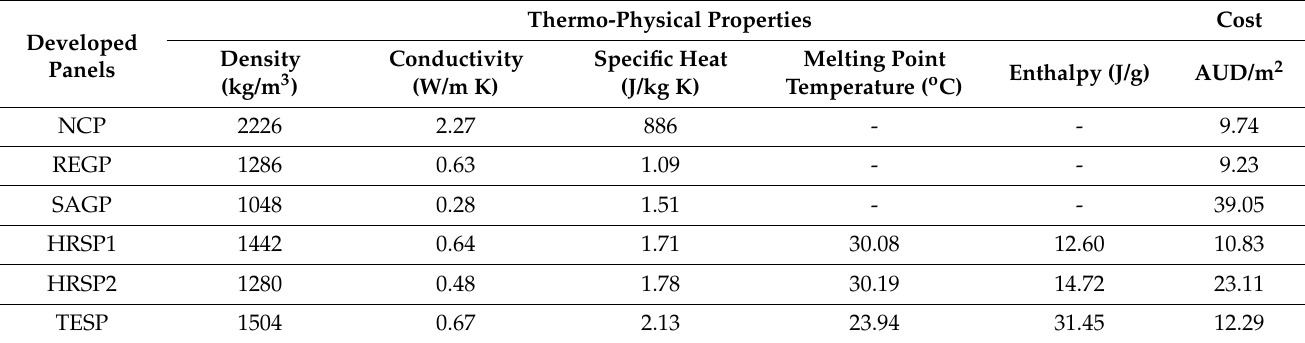
Table 3. Thermo-physical properties of thermally enhanced construction materials [15,17]. Developed